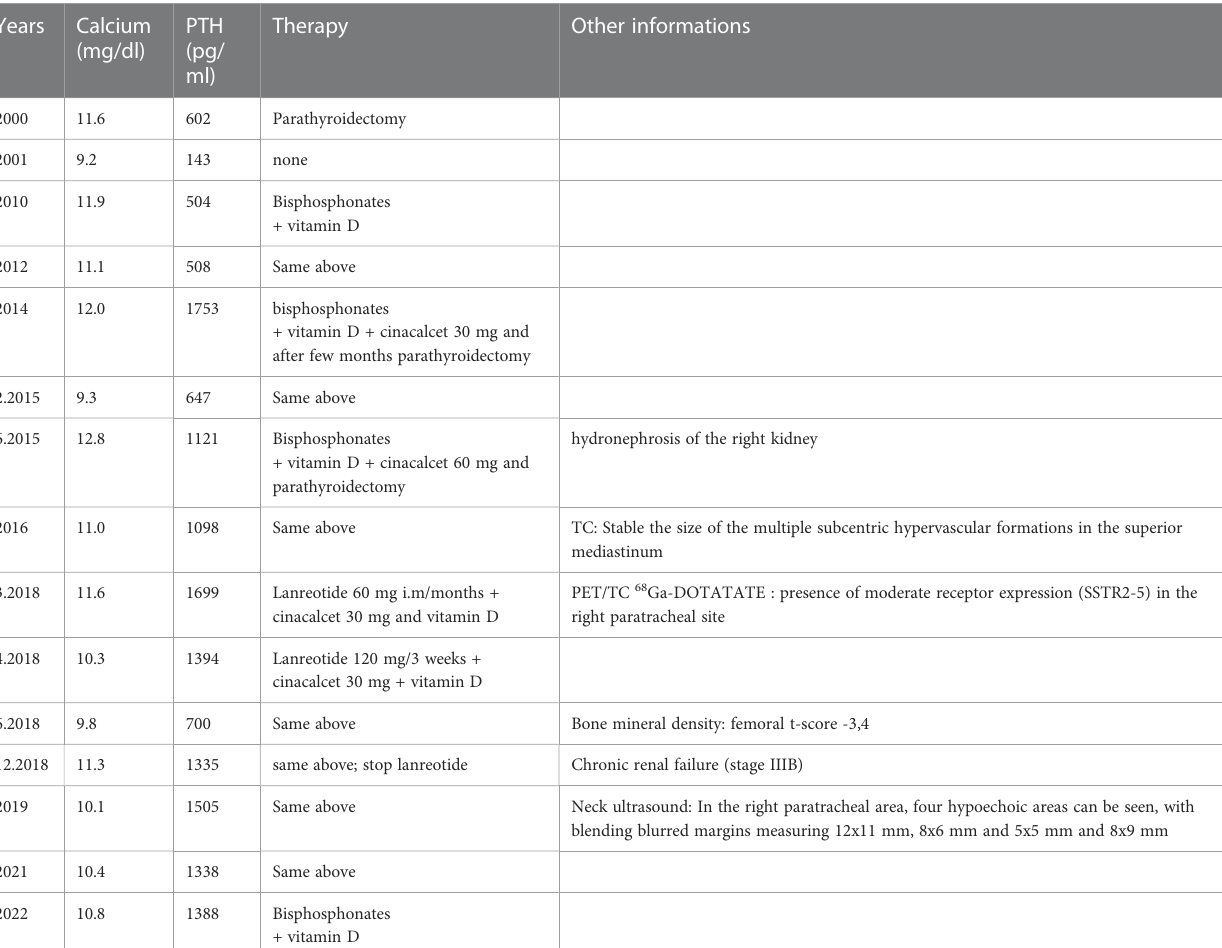
TABLE 1 Calcium and PTH values, therapy and other informations throughout the years.